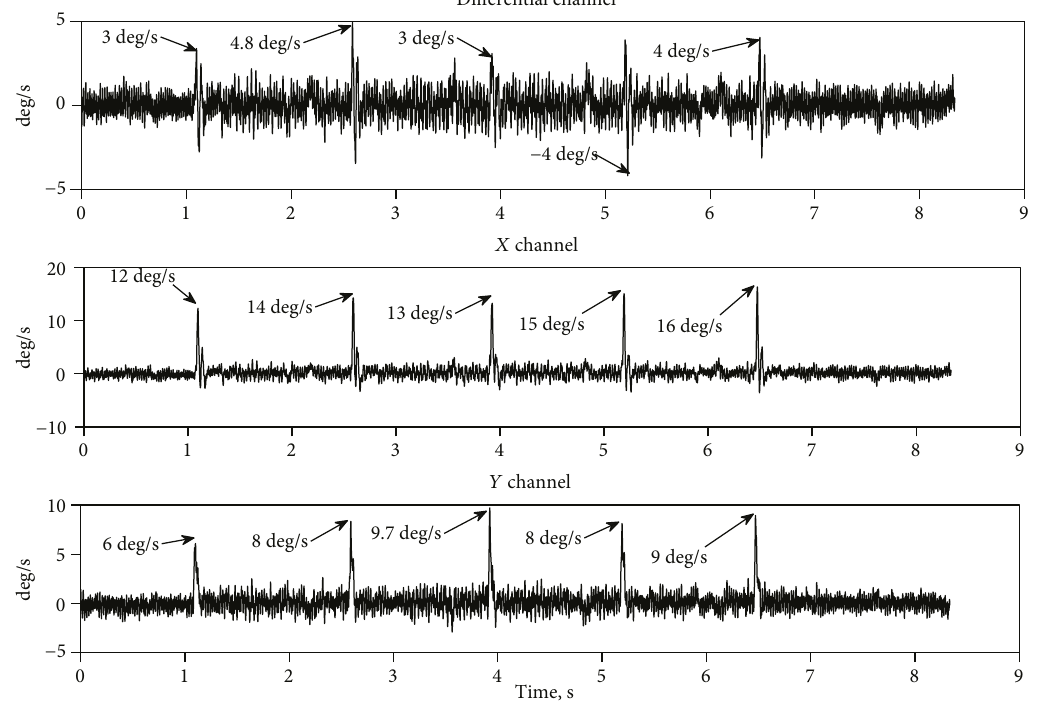
Figure 6: Responses to fi ve lateral shocks of 20 g amplitude.